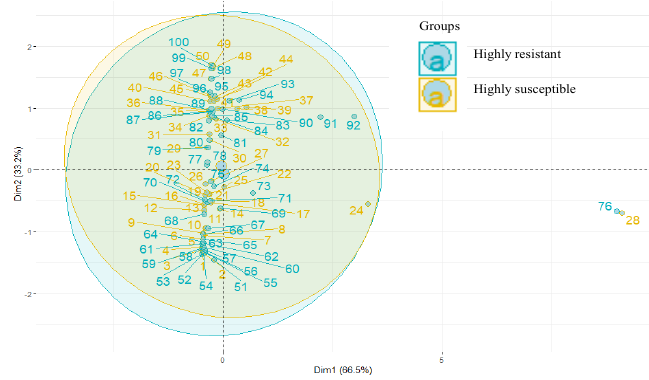
Figure 6. Principal component analysis of metabolites.